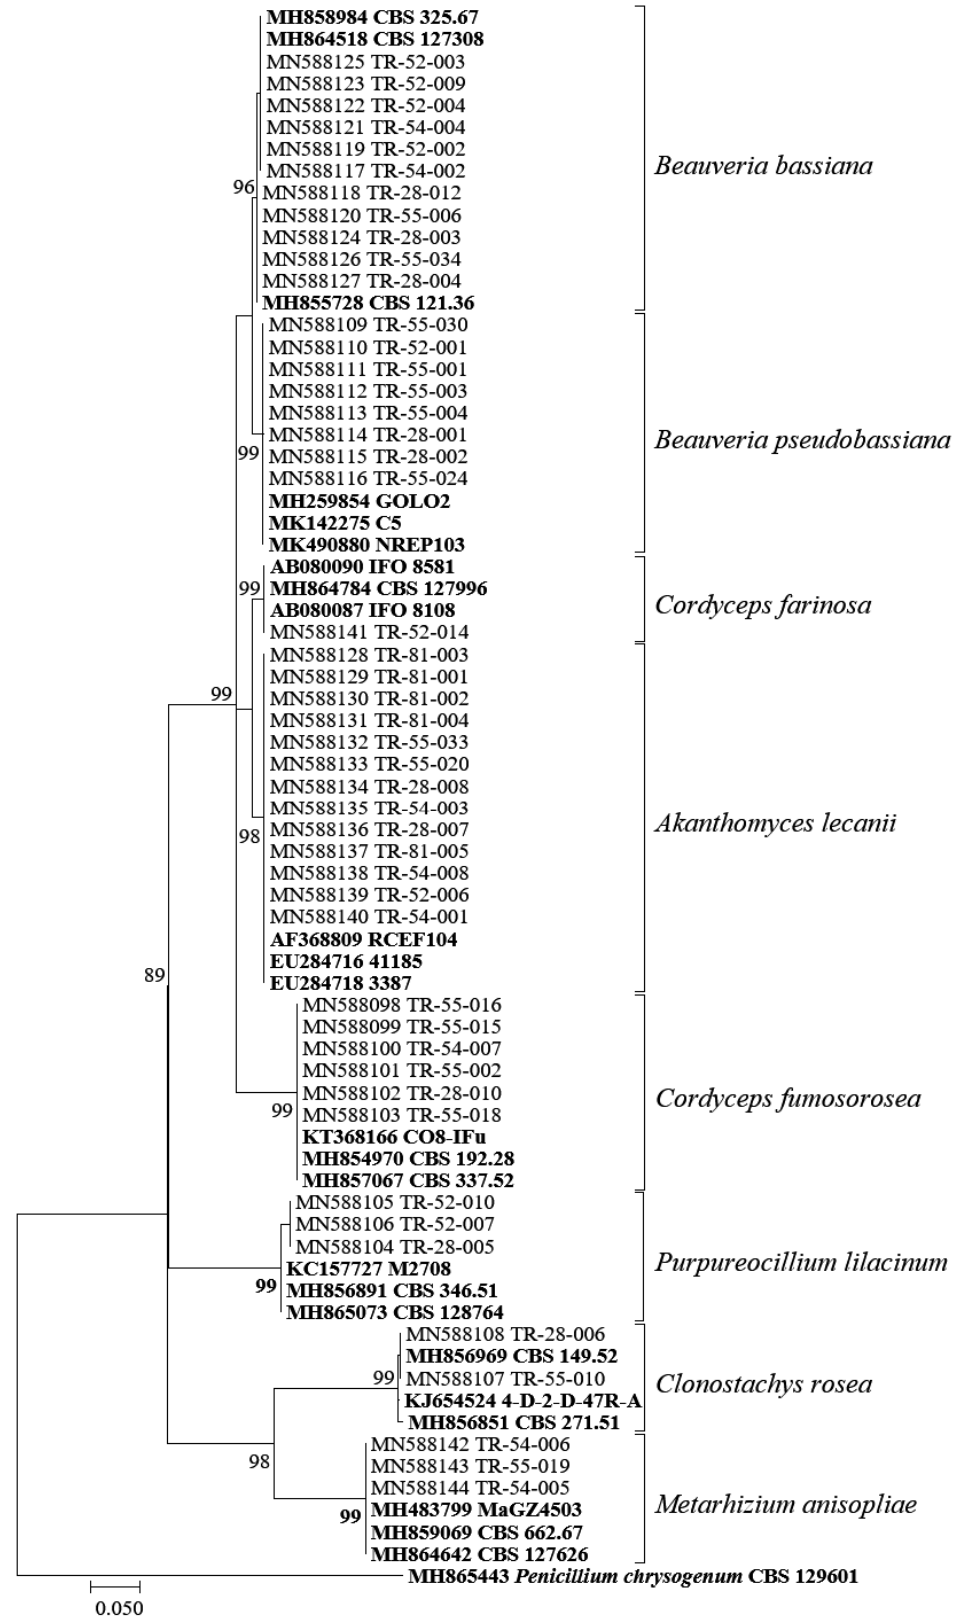
Figure 1. Maximum-likelihood (ML) phylogenetic tree generated from the ITS dataset of ento- mopathogenic fungal isolates. Bootstrap values are shown for each node.